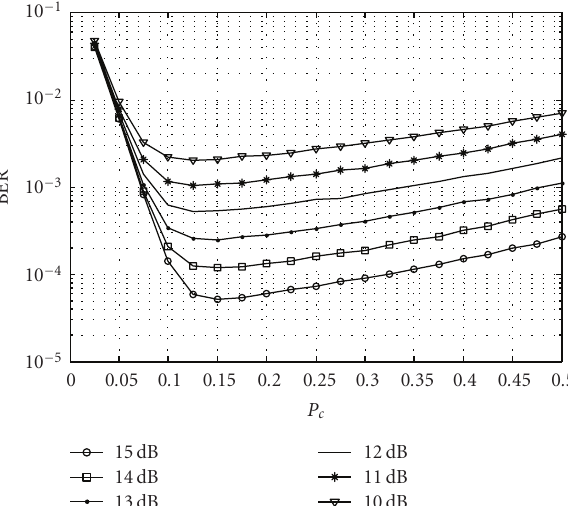
Figure 8: BER comparisons for various channel estimation tech- niques.